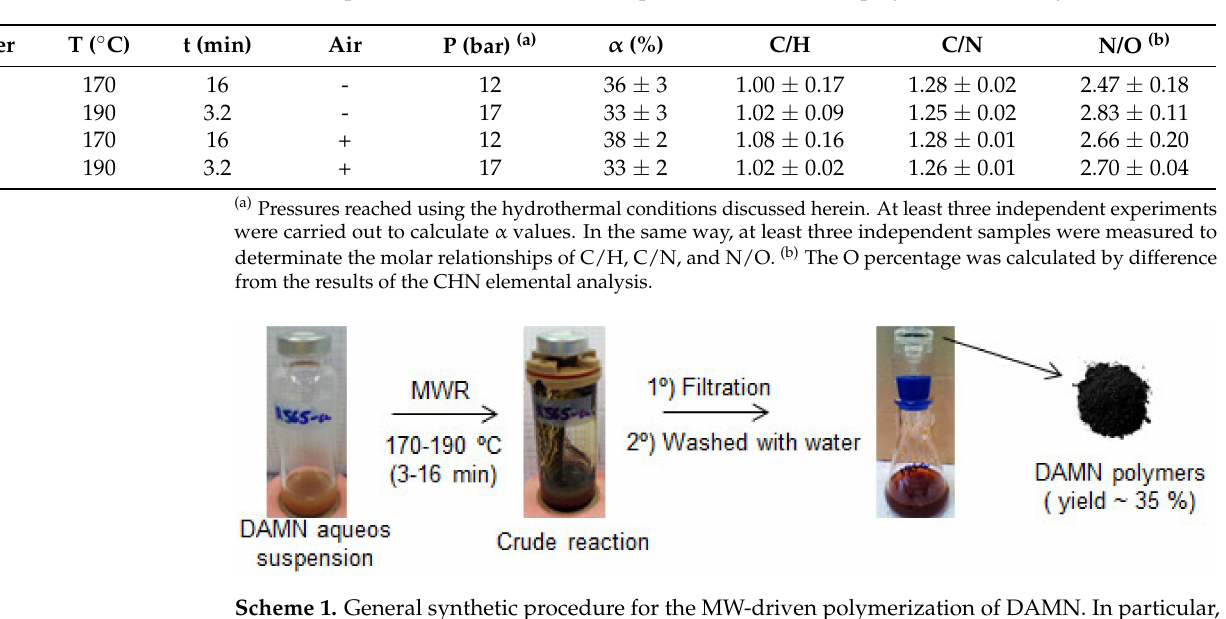
Table 1. Experimental conditions for the production of DAMN polymers assisted by